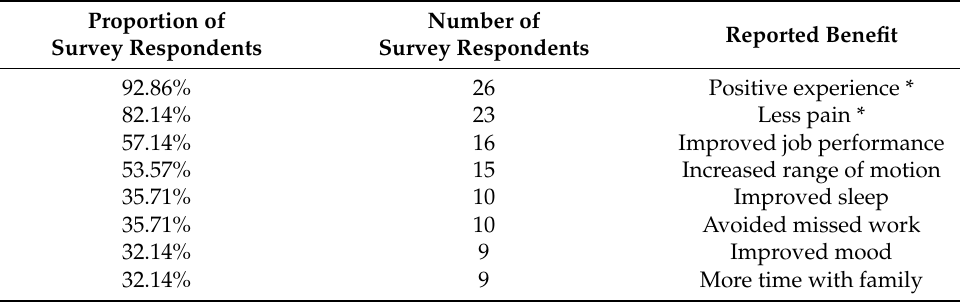
Table 1. Proportion of Participants Reporting Benefits of H-Wave Device ®